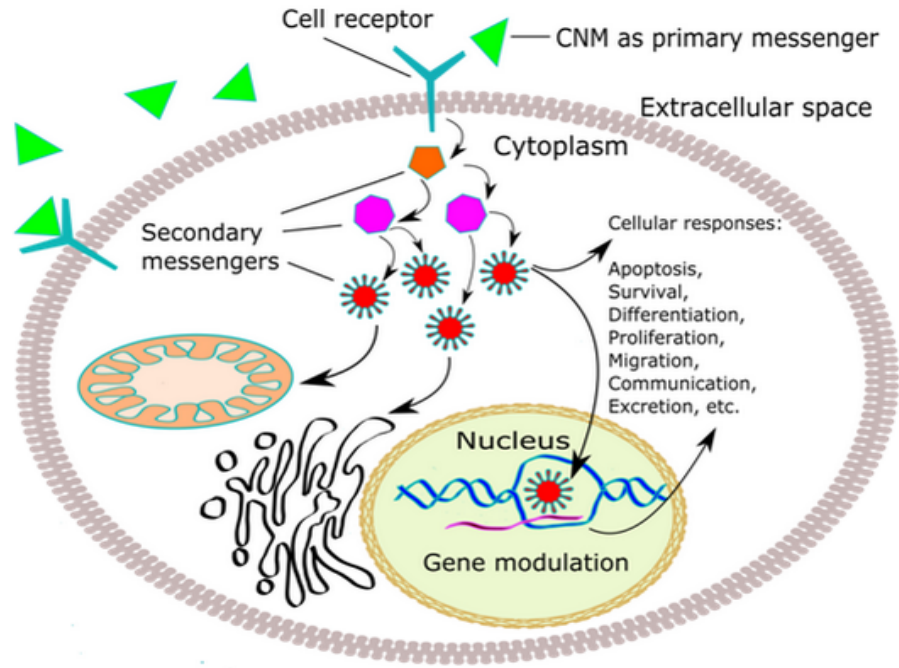
Figure 4. General scheme of cell signaling cascade, original figure.